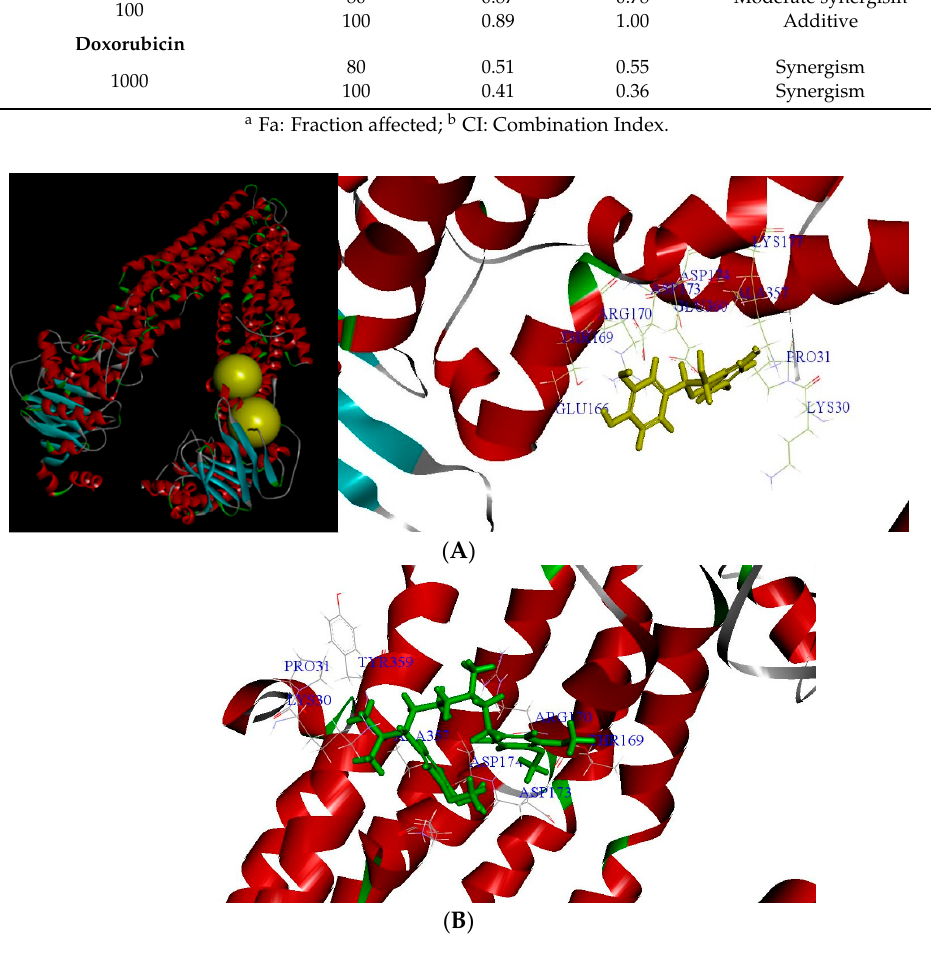
Table 3. The -CDOCKER Energy score of screened compounds.